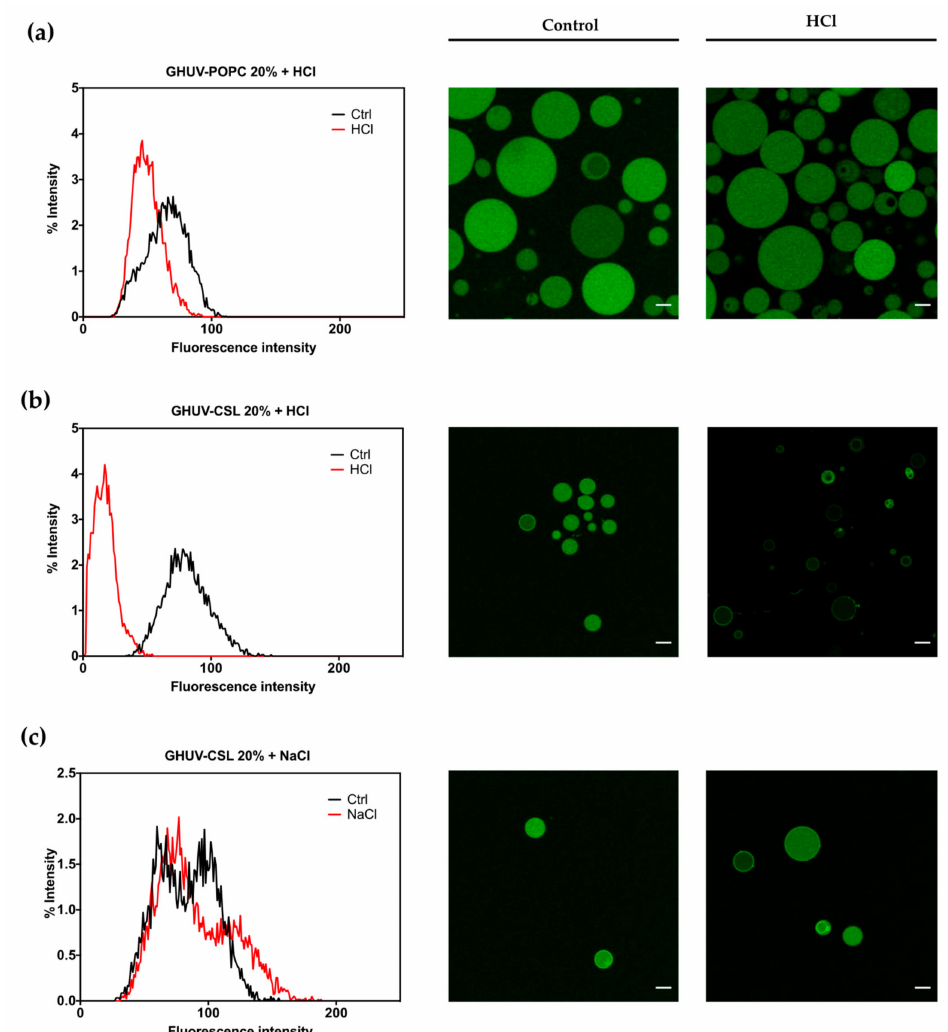
Figure 3. Overall calcein fluorescence intensity distribution in GHUVs before and after acidification. ( a ) Overall intensity in GHUV-POPC 20% followed by confocal pictures before and after acidification; ( b) overall intensity of loaded-calcein in GHUV-CSL3 20% followed by representative pictures before and after acidification or ( c) NaCl treatment. Scale bar: 10 µ m. Calcein